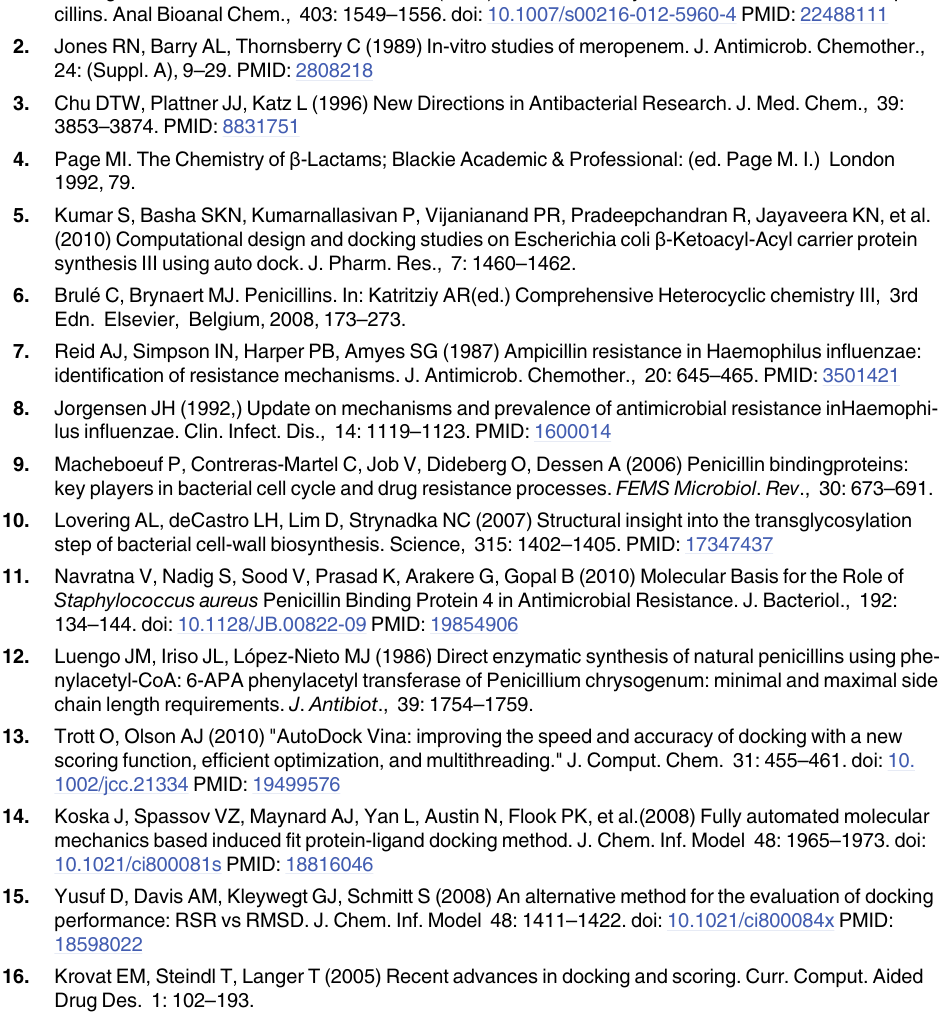
S1 Table. Descriptions of the various types of interactions between inhibitors and target protein functionalities shown in